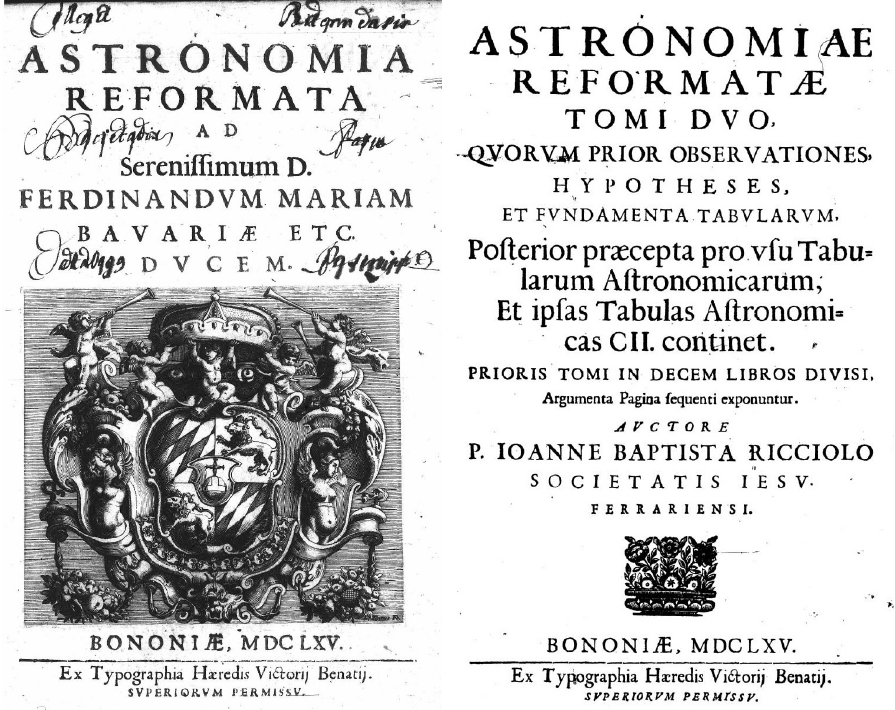
Fig. 2. Title pages from Riccioli’s Astronomia Reformata . According to Edward Grant, unlike many of his colleagues who were \not scientists properly speaking but natural philosophers in the medieval sense using problems in Aristotle’s De caelo and Physics as the vehicle for their discussions, Riccioli was a technical astronomer and scientist [Grant 1984, p. 12]." Riccioli was very concerned with accuracy in measurements and observations, at one point recruiting nine of his Jesuit colleagues for the task of counting the swings of a pendulum over a twenty-four hour period, timed by transits of stars, in order to accurately calibrate it so he could time falling bodies { and then repeating the process to improve upon the results (Heilbron 2001, p. 180{181). His reports on the appearance of Jupiter should be considered in light of this concern for